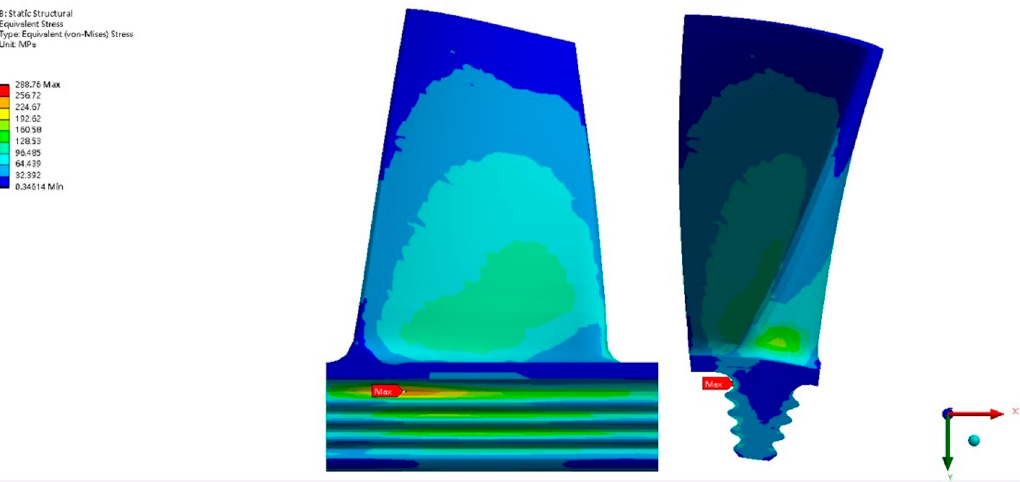
Figure 14. Stress result of centrifugal force analysis of the 1st stage moving blade.